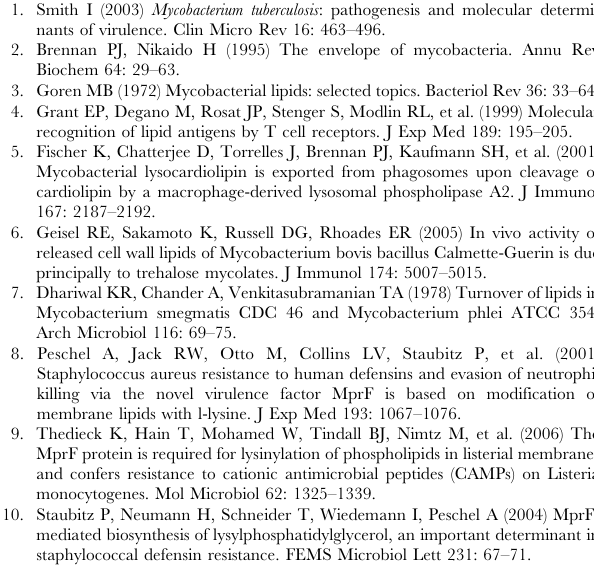
between the SDS treated and untreated groups were noted. Data shown are mean 6 standard error. Figure S4 Growth of the lysX mutant in the spleen of mice and guinea pigs. Growth of the lysX mutant and Rv-03 strain in the spleens of mice -A- and guinea pig -B. Following aerosol infection of mice and guinea pigs, spleens were harvested at the indicated time points. Homogenates were prepared, and viability was determined on agar plates. The lysX mutant showed reduced and/ or delayed dissemination compared to wild type in both animal models. Figure S5 Neutral red staining and PDIM analysis: Panel A: Wild type and lysX mutant cells were stained with neutral red and photographed. As a control, the attenuated strain Mtb H37ra was used. Panel B: The lipids were separated by silica thin-layer chromatography (TLC) with hexane:diethylether:acetic acid (80:20:1, vol/vol/vol) as solvent system. The lipids were visualized by spraying with 10% phosphormolybdate in ethanol followed by heating to about 110 u C for 15